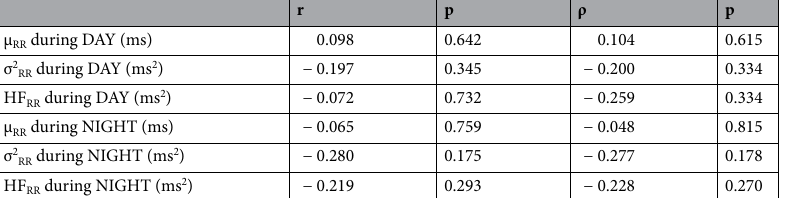
Table 3. Results of the correlation between heart rate variability indices and children’s age. DAY, daytime; NIGHT, nighttime; μ error